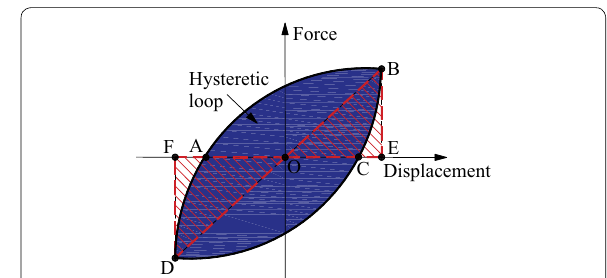
Fig. 11 Diagram of equivalent viscous damping coefficient calculation